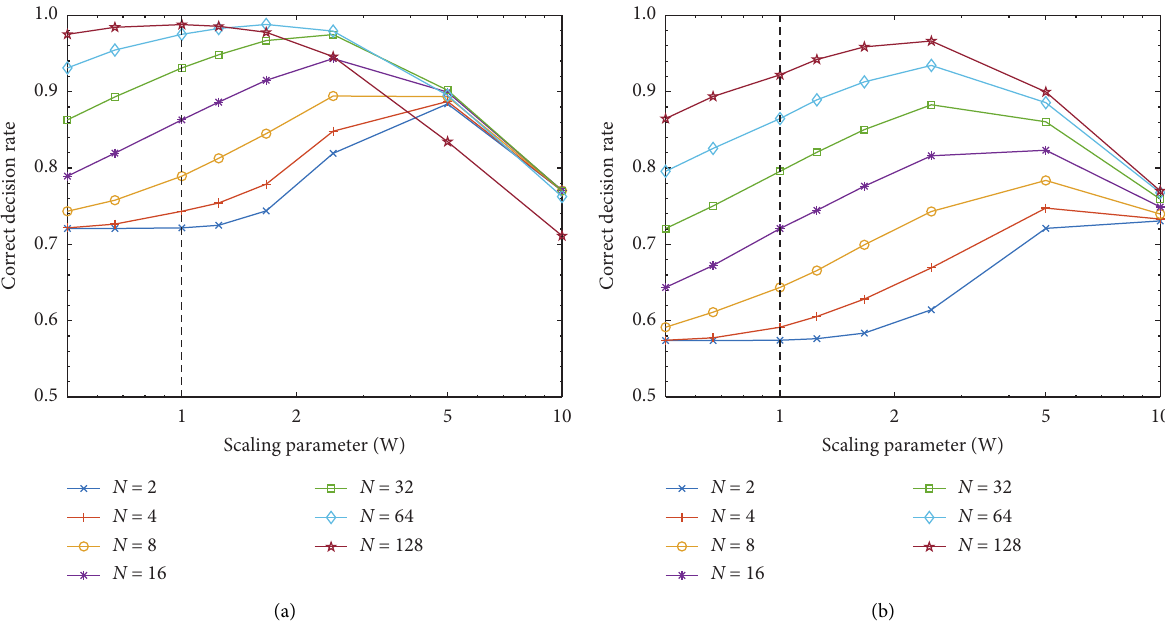
Figure 7: CDR with introducing and tuning the parameter W : (a) P